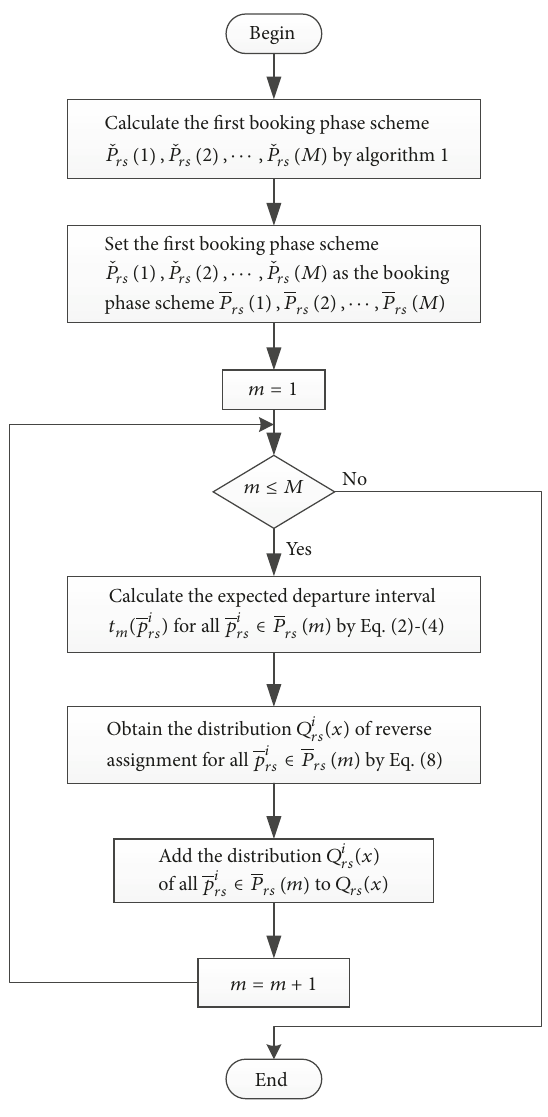
Figure 3: The flow diagram of the SBPRA algorithm.